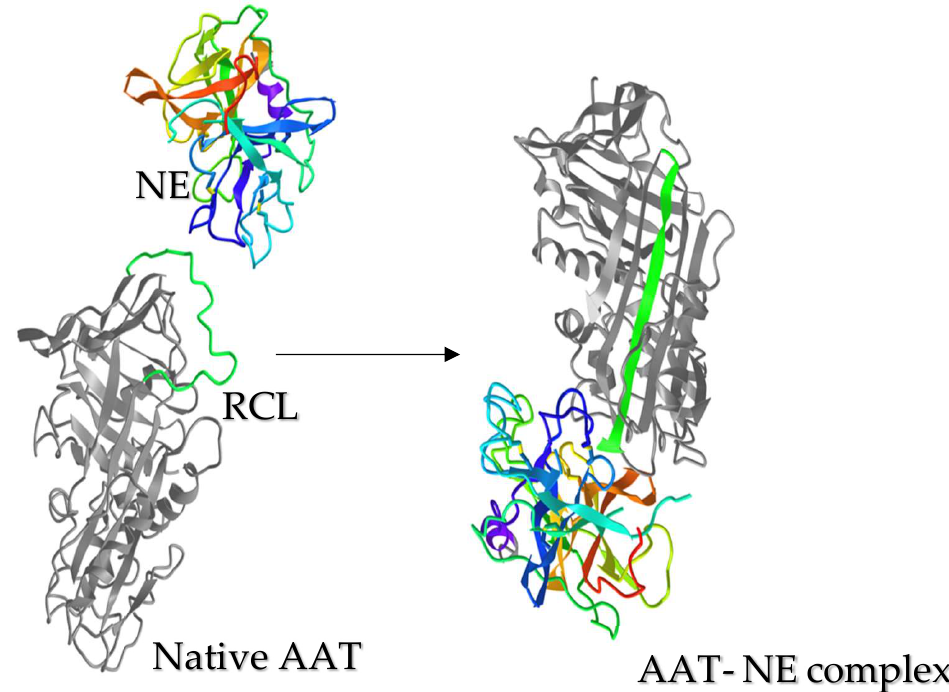
Figure 2. AAT- NE complex formation. Neutrophil elastase (NE) and AAT, shown at the same relative scale. Upon proteolytic cleavage by NE, the reactive center loop (RCL;green) of AAT is incorporated to form the central b strand of the A-sheet (green, right). This conformational change translocates